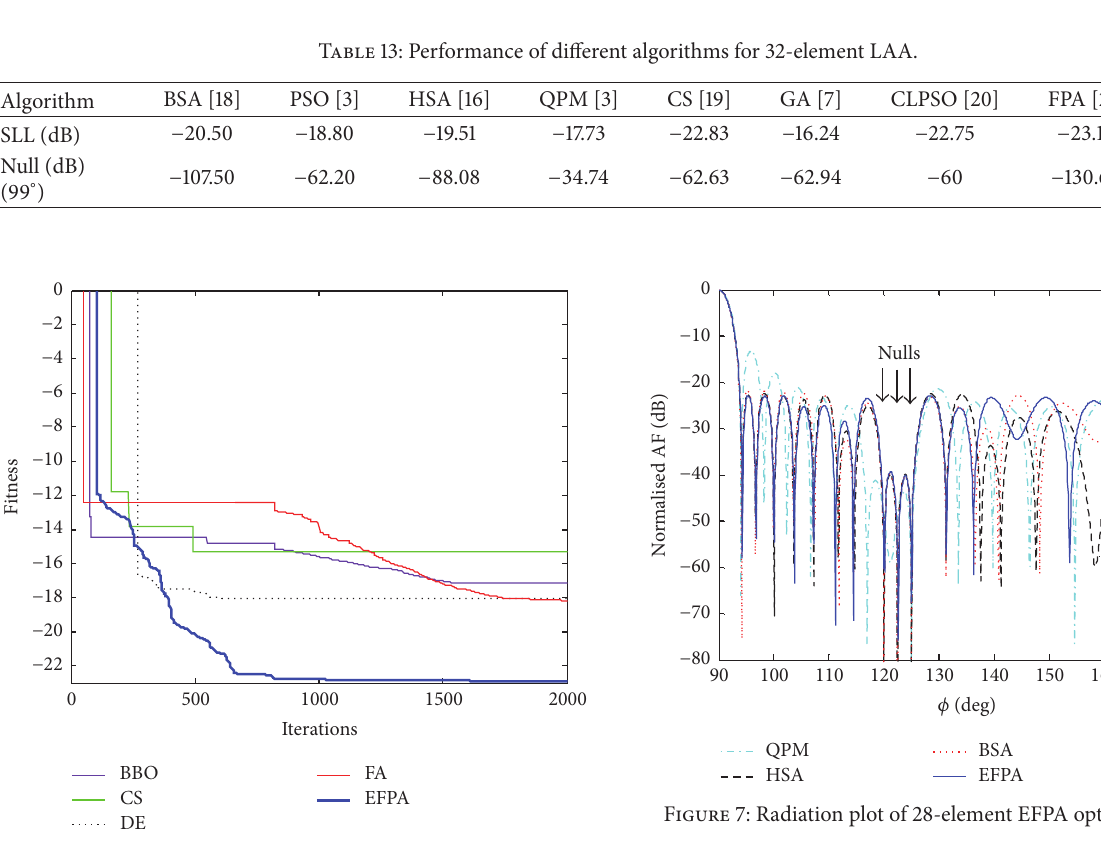
Figure 6: Convergence plots of 28-element LAA.